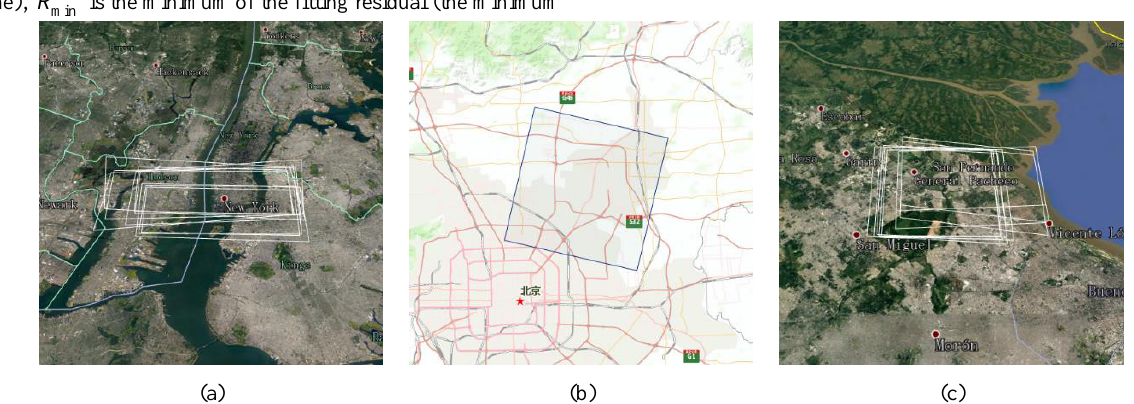
Figure 2. The coverages of the datasets. (a)The coverage of the JL1 dataset. (b)The coverage of the GF2 dataset. (d)The coverage of the WV3 dataset.